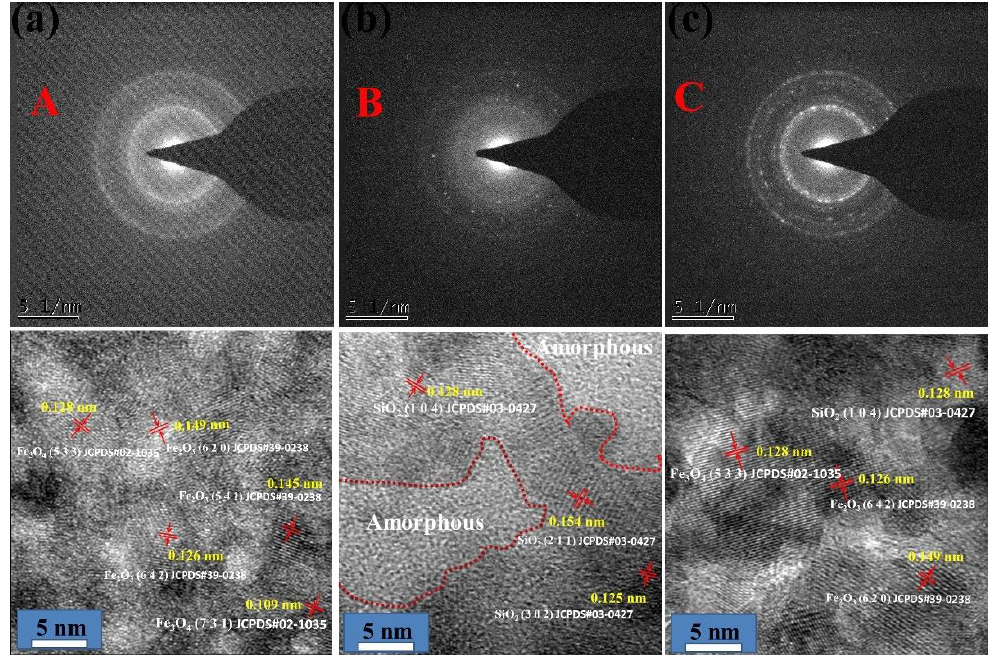
Figure 11. High-resolution TEM image of specified regions in Figure 9a.